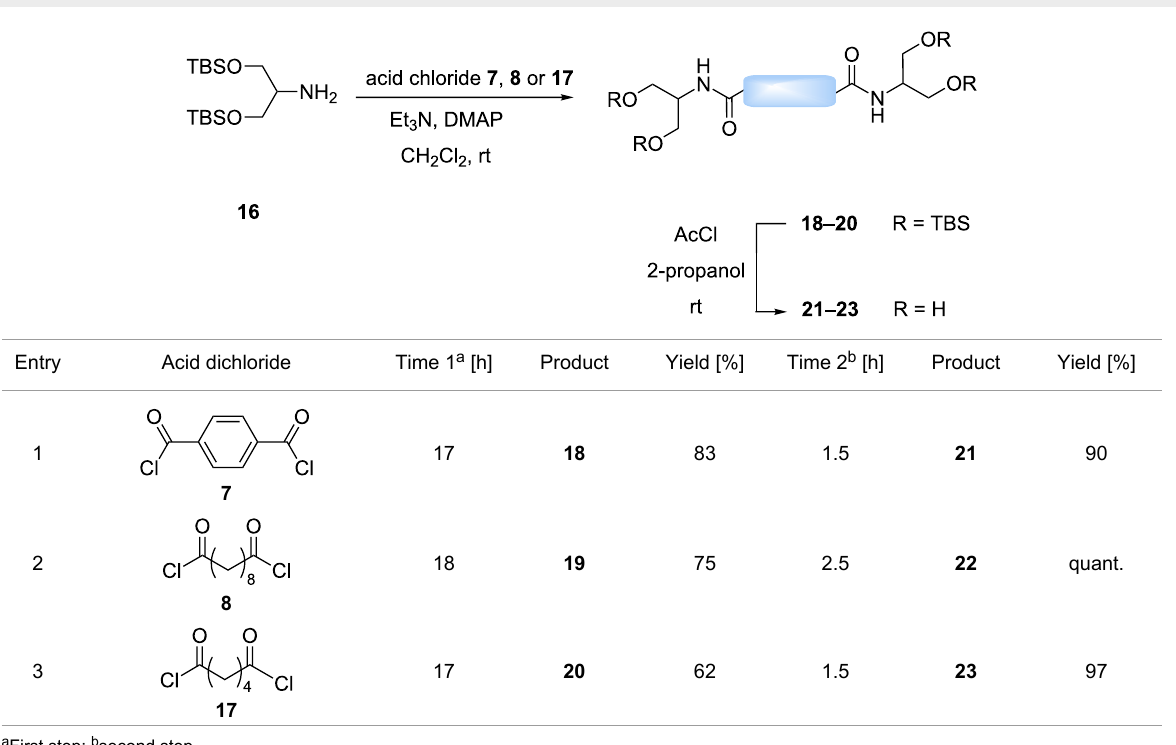
Table 2: Synthesis of amides 18 – 20 from protected serinol 16 and subsequent deprotection to give divalent compounds 21 – 23